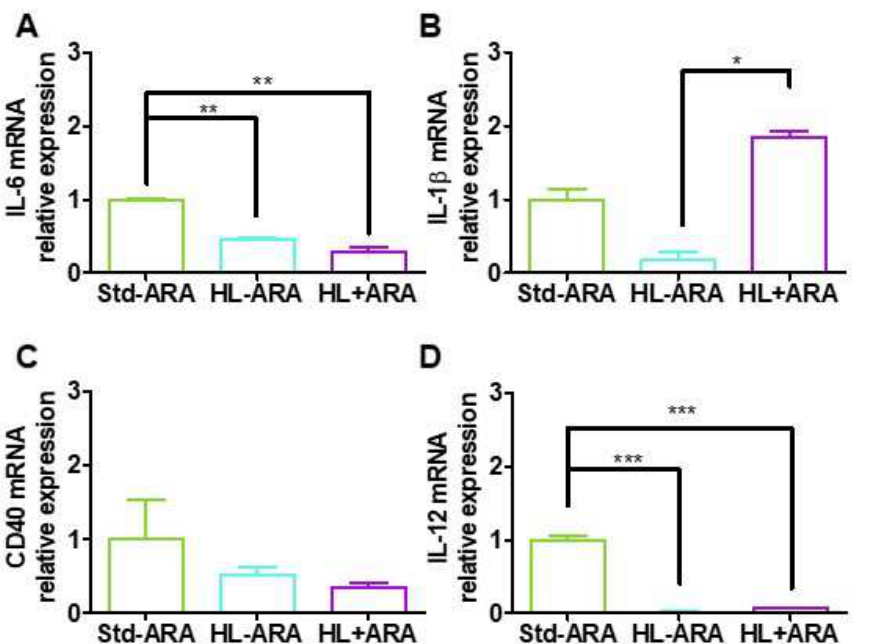
Figure 5. Half-brain gene expression of IL-6 ( A ), IL-1 β ( B ), CD40 ( C ), and IL-12 ( D ) at 9 weeks of diet. Data are represented as the mean ± standard error of the mean (SEM). n = 2 mouse per diet group. * p < 0.05, ** p < 0.01, and *** p < 0.001. Data analyzed by one-way ANOVA test and Bonferroni’s multiple comparisons test for post hoc analysis or Kruskal–Wallis-test and Dunn’s multiple comparisons test for post hoc analysis.